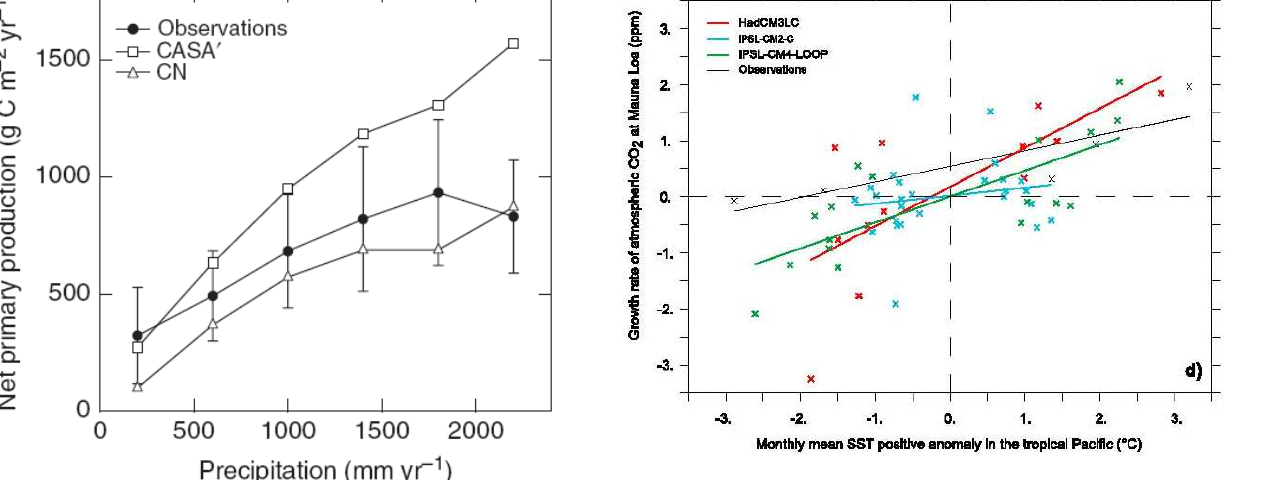
Fig. 5. CO 2 –temperature relationships used in a benchmark analysis to show the positive and negative anomalies of atmospheric CO 2 growth rate as a function of anomalies of eastern tropical Pacific sea surface temperature (SST) (adopted from Cadule et al., 2010). itoring (CALM; http://nsidc.org/data/ggd313.html)